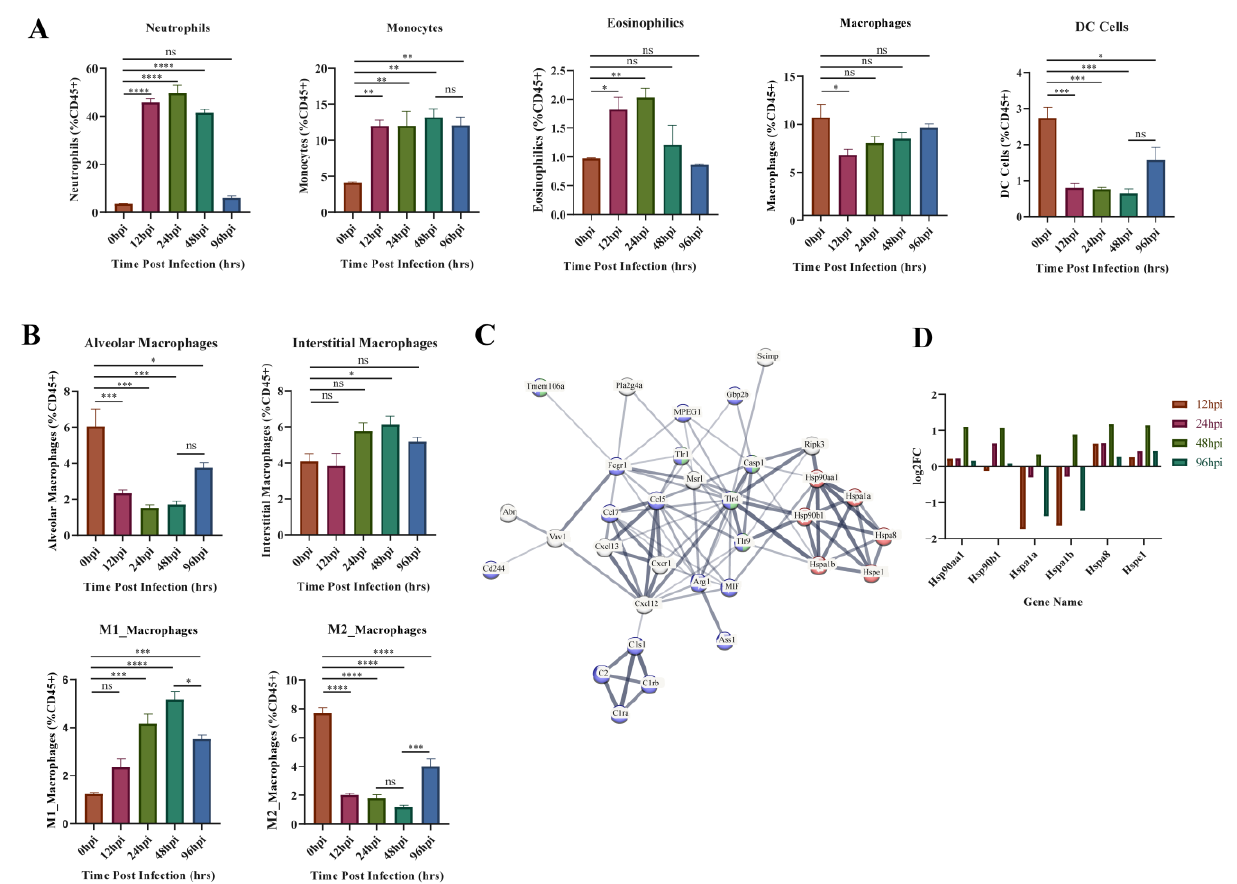
Figure 6. Flow cytometry and module 1 PPI network results. ( A ) Flow cytometric analysis of five major innate immune cells. ( B ) Flow cytometric analysis of four subtypes of